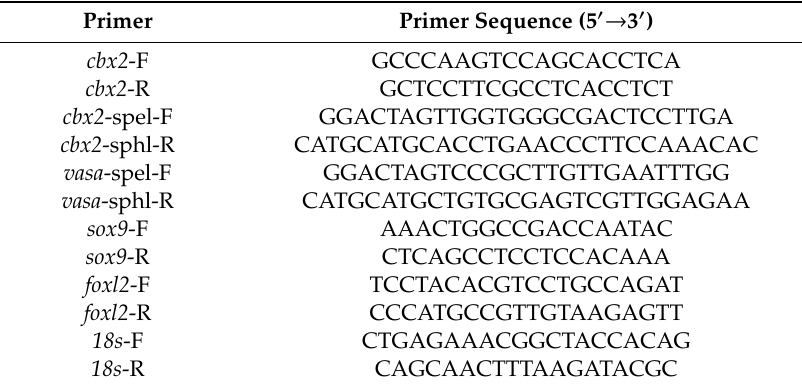
Table 1. Primers for real-time PCR and probe